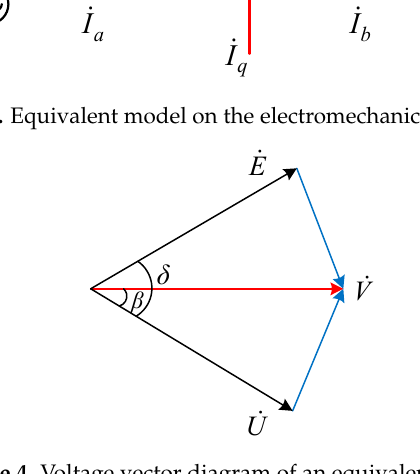
Figure 3. Equivalent model on the electromechanical time scale.